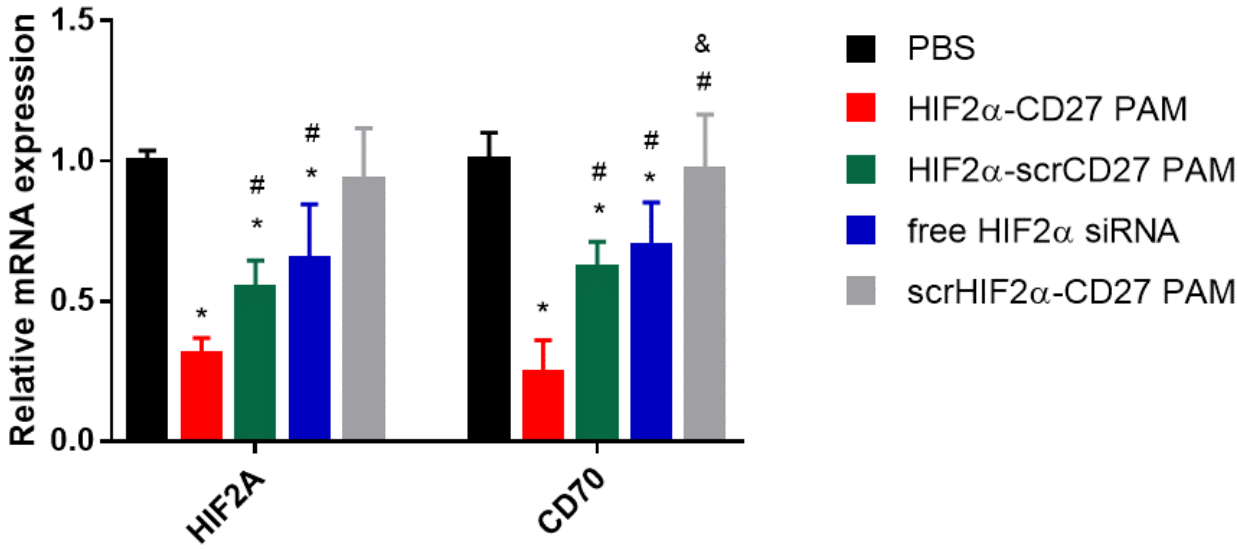
Figure 4. mRNA expression of HIF2A (left) and CD70 (right) following 48 h treatment with HIF2 α - CD27 PAMs. The 48 h HIF2 α -CD27 PAM treatment (500 nM siRNA) significantly reduced HIF2A and CD70 mRNA expression compared to non-targeted PAM and free siRNA controls in patient-derived ccRCC cells. N = 5. * p < 0.05 relative to PBS. # p < 0.05 relative to HIF2 α -CD27 PAMs. & p < 0.05 relative to HIF2 α -scrCD27 PAMs.